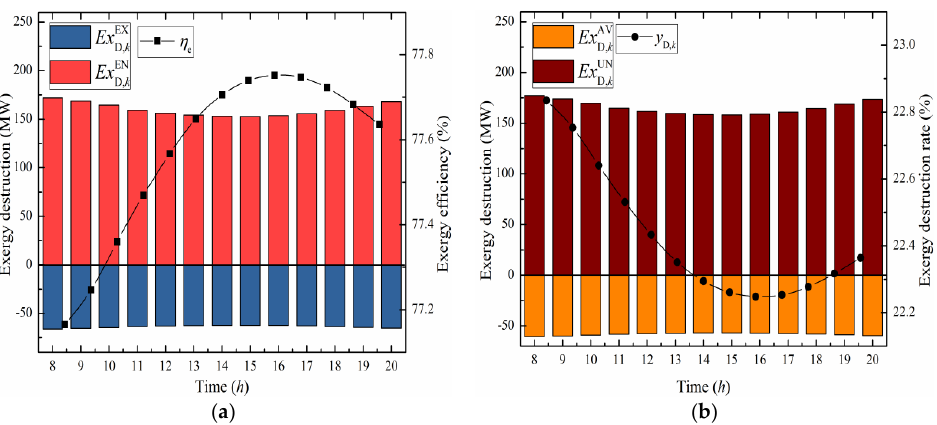
Figure 5. The exergy destruction, exergy efficiency and exergy destruction rate of CC variation with time. ( a ) The endogenous/exogenous exergy destruction and exergy efficiency variation with time. ( b ) The avoidable/unavoidable exergy destruction and exergy destruction rate variation with time.